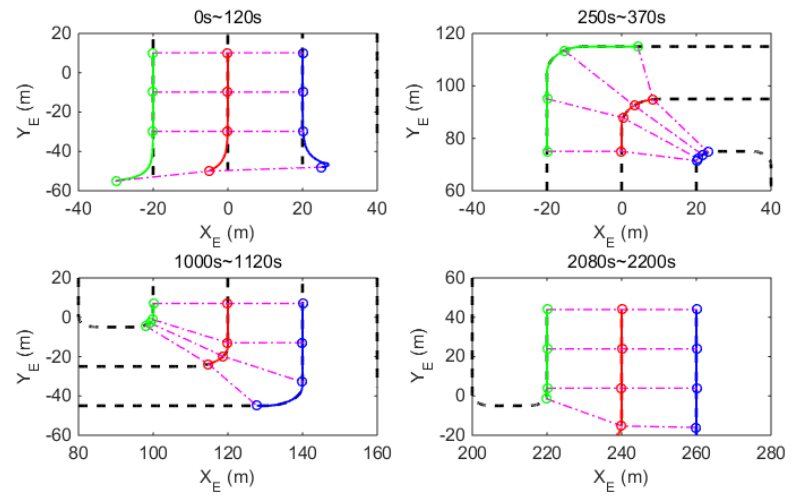
Figure 6. Snapshots of three AUVs in different time periods.